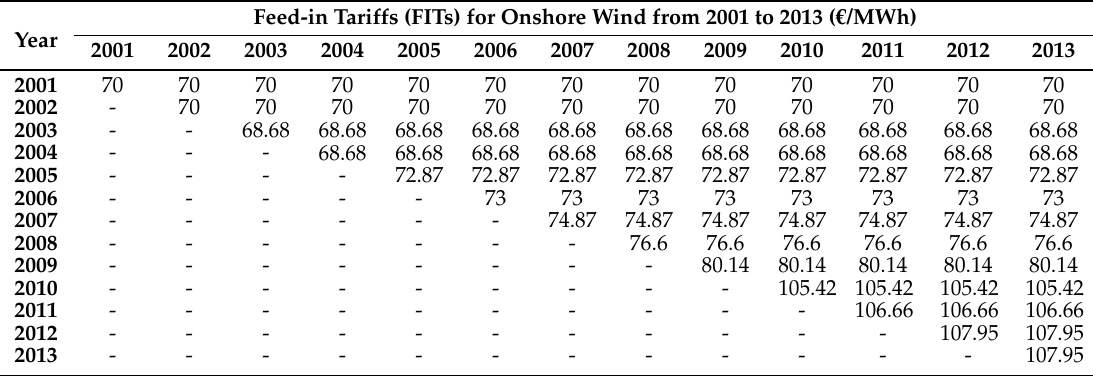
Table 1. Feed-in tariffs (FITs) for onshore wind from 2001 to 2013.